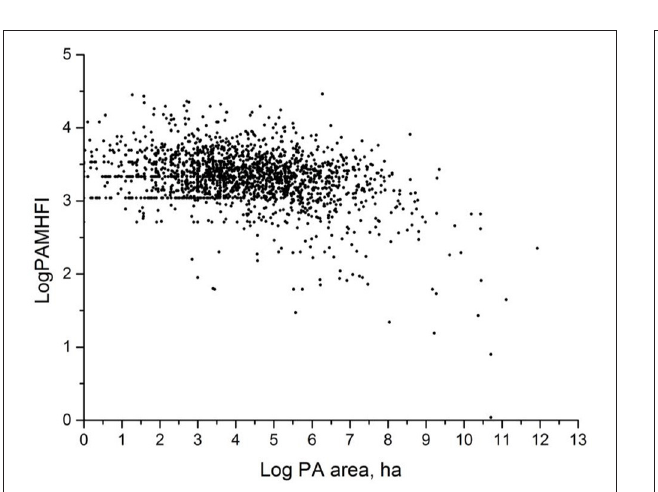
FIGURE 2 | Log-log regression of PAMHFI against PA area. log PAMHFI = 1.573–0.074 log area, β < 0 ( p < 0.001), R 2 = 0.12.